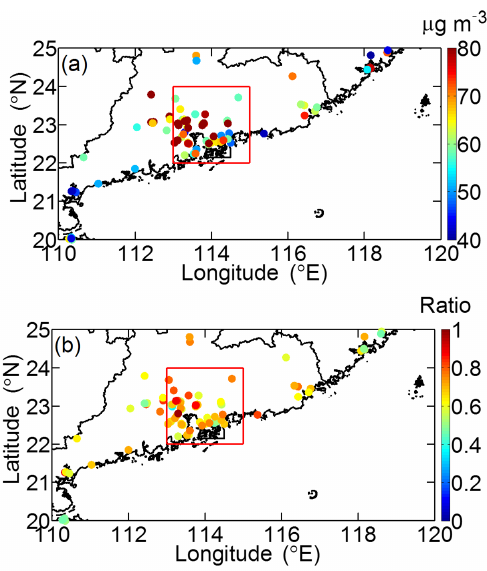
Figure 1. Spatial distributions of (a) ground-based mean PM 10 (in µgm − 3 ) and (b) the ratio of mean PM 2 . 5 to mean PM 10 simul- taneously measured for the period from November 2013 to Octo- ber 2014. The red box outlines the PRD region; the dots show the locations of the PM measurement